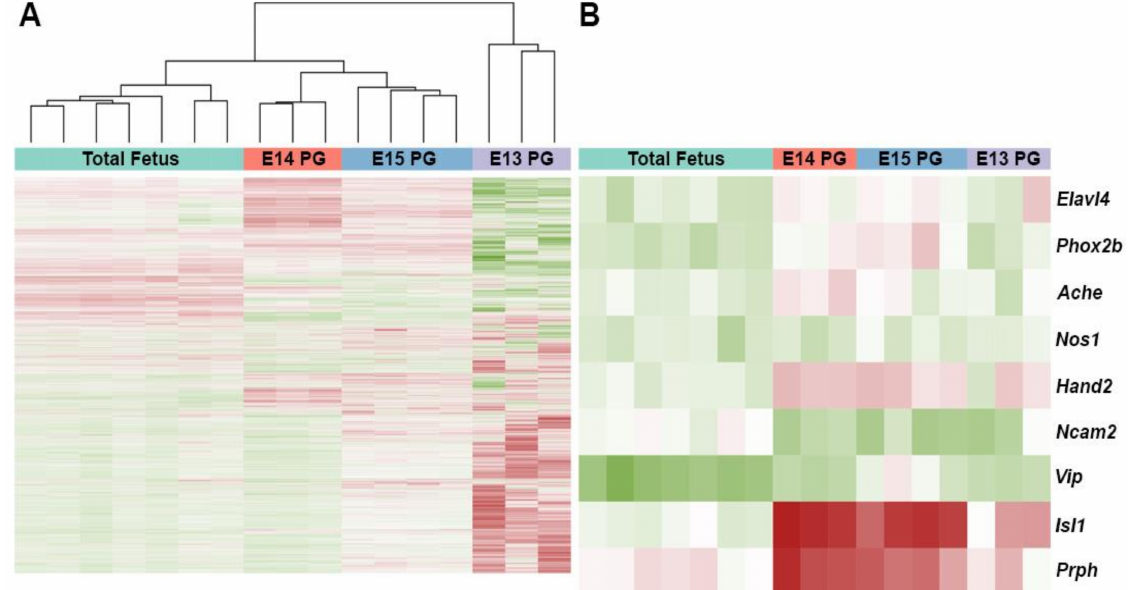
Figure 2. Microarray hybridization clustering of RNA isolates from fetal mouse pelvic ganglia compared to whole embryo control replicates. ( A ) Heat map displaying consistent gene expression patterns within biological replicates of control and experimental samples based on unsupervised, unbiased clustering using all genes. Each horizontal line represents expression detected by one probe set. Increased hybridization relative to control tissue is indicated by red, whereas green bars indicate decreased gene expression relative to total embryo control hybridization signals. ( B ) Heat map reflecting expression of control genes that were expected to be up-regulated in neuronal cell types across all compared samples. The graphic shown depicts clusters based on gene